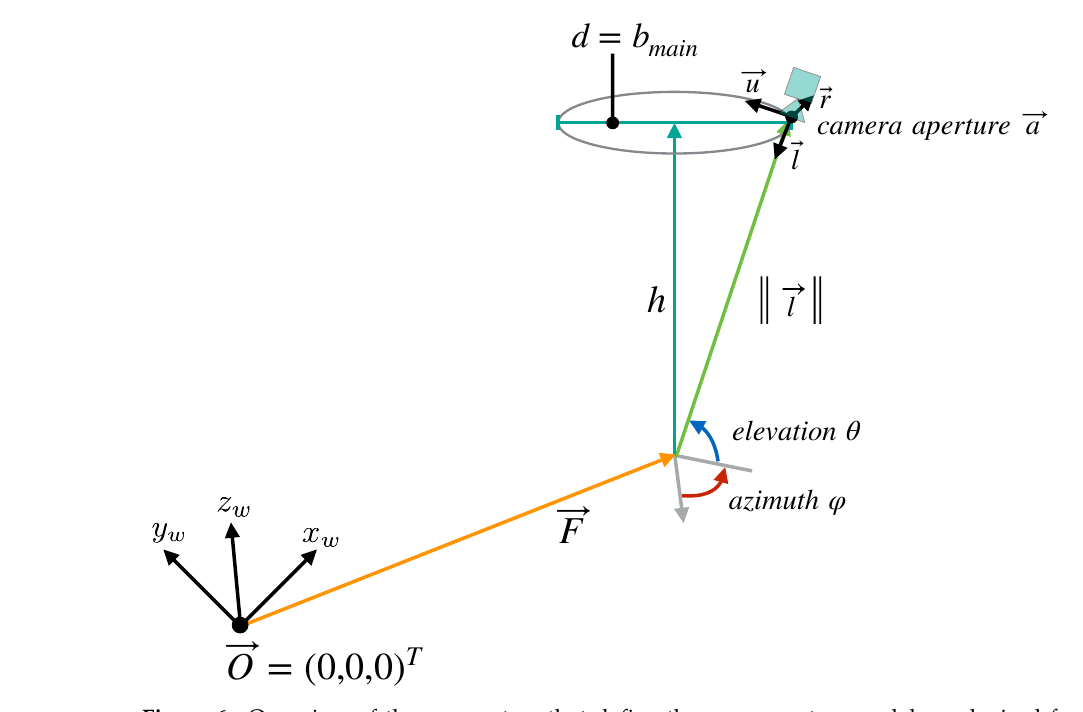
Figure 6. Overview of the parameters that define the camera setup model we devised for our simulation. The cameras lie on a ring with the diameter d , at the distance h from the reference point (cid:126) F , which all cameras look at. The distance h is equivalent to the working distance of the fully digital microscope simulated by the model, while d is the maximum baseline b main allowed by the microscope’s main objective. The points on the ring can be described in spherical coordinates relative (cid:13) (cid:13) (cid:126) l (cid:13) (cid:13) to (cid:126) F . In these coordinates, (cid:13) (cid:13) is equal to the main objective’s focal